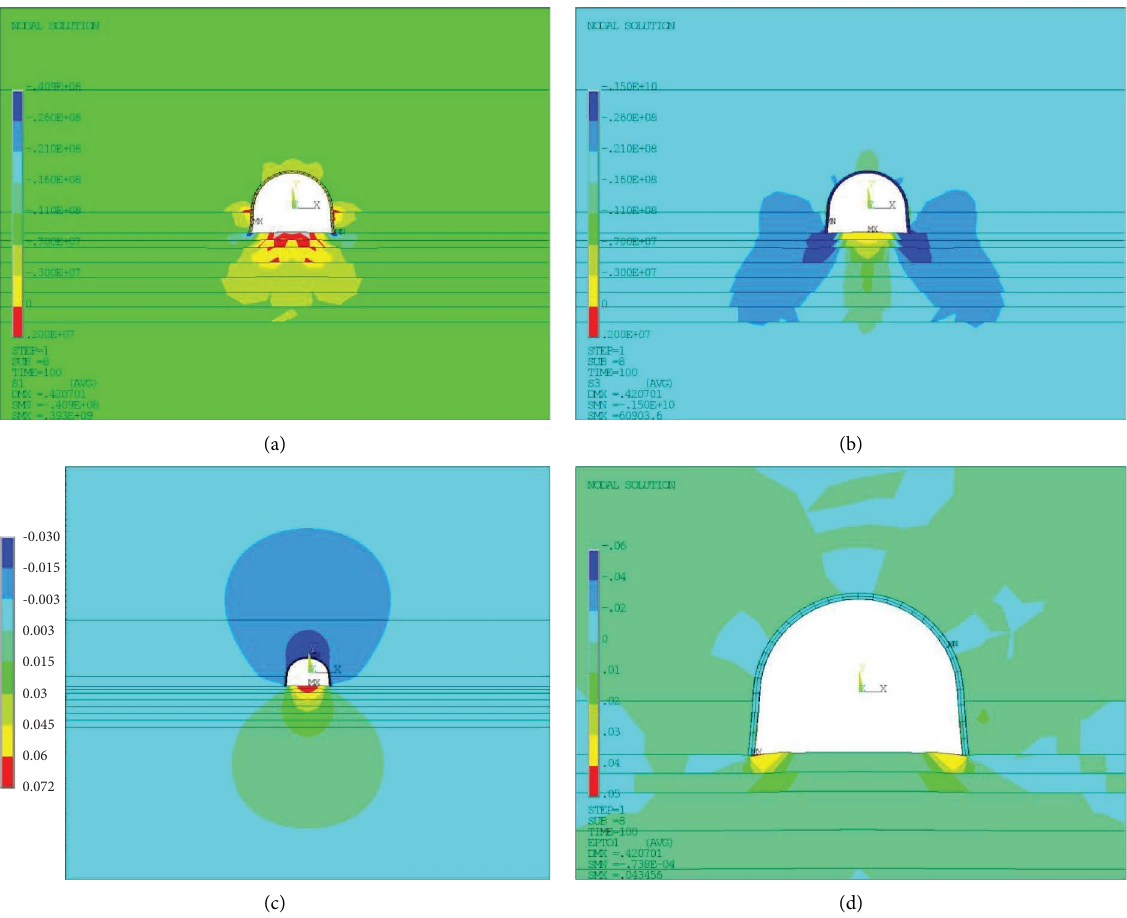
Figure 6: Te results of numerical calculation in the case of roadway development: (a) distribution of maximum ( σ distribution of minimum ( σ 3 ) principal stresses; (c) distribution of vertical displacement; (d) distribution of maximum principal